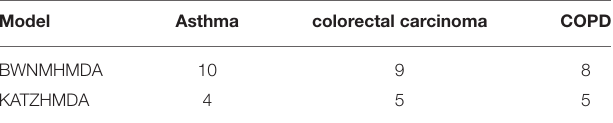
TABLE 7 | The number of of microbes having been confirmed by evidences in the top 10 potential disease-related microbes predicted by BWNMHMDA and KATZHMDA respectively in case studies of the three kinds of diseases such as Asthma, CRC, and